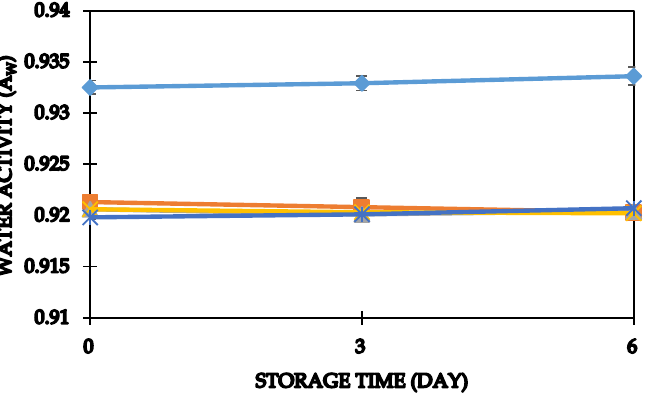
Figure 2. Water activity profile in bread during storage. The bars indicate standard errors of means. White bread ( ♦ ); 20% OFSP bread ( ■ ); 30% OFSP bread ( ▲ ); 40% OFSP bread ( ∗ ); 50% OFSP bread ( ∗ ).